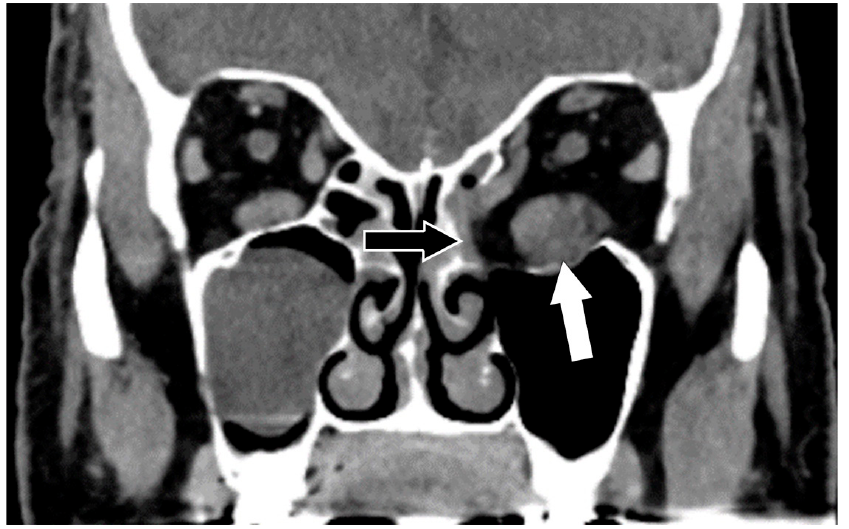
Figure 1. Graves’ eye disease. Coronal CT with contrast shows an enlarged left inferior rectus muscle (white arrow) and post-operative changes following decompressive surgery in the infero-medal left orbital wall and the medial aspect of the left orbital floor (black